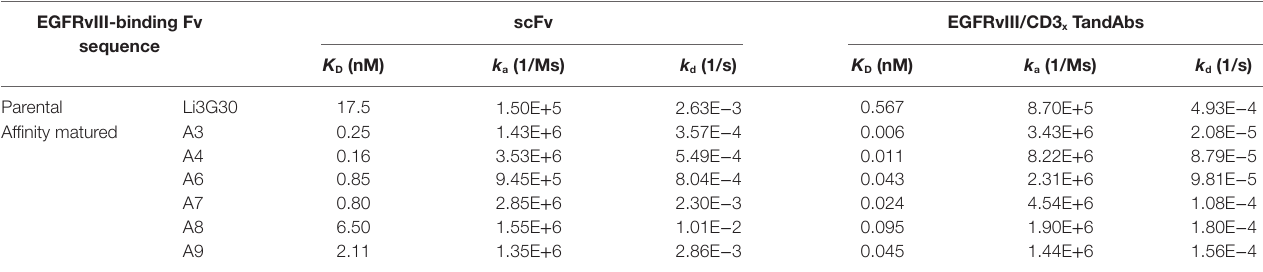
TaBle 1 | egFrviii-specific antigen-binding constants of monovalent scFv and bivalent tandem diabody (Tandab) antibody variants containing de novo identified (parental) or affinity matured egFrviii-binding Fv sequences measured by sPr. egFrviii-binding Fv